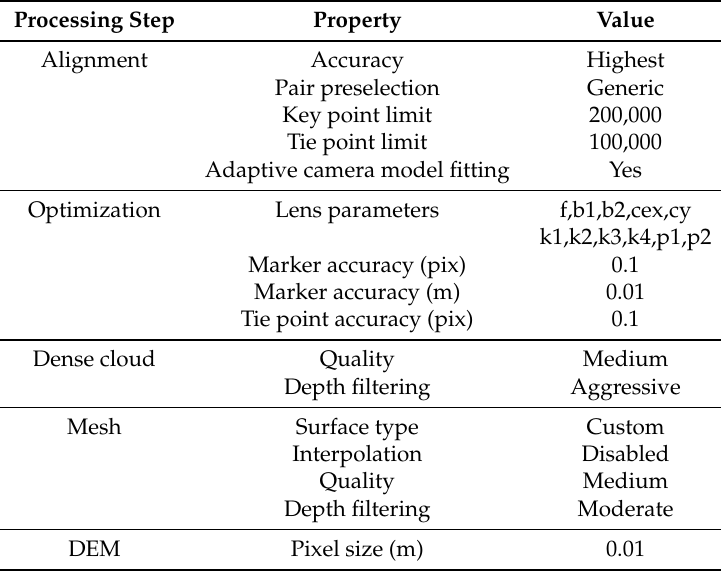
Table 1. Parameters used in PhotoScan Pro ©